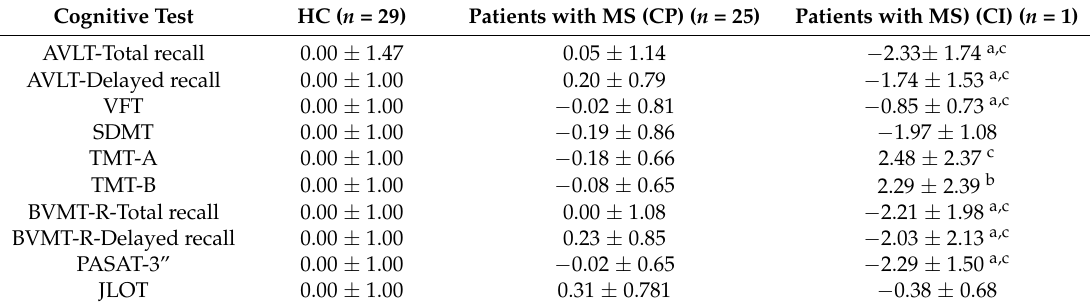
Table 7. Comparison in cognitive tests among the MS patients with CI, MS patients with CP, and HCs. Cognitive Test HC ( n = 29) Patients with MS (CP) ( n = 25) Patients with MS) (CI) ( n = 1) AVLT-Total recall 0.00 ± 1.47 0.05 ± 1.14